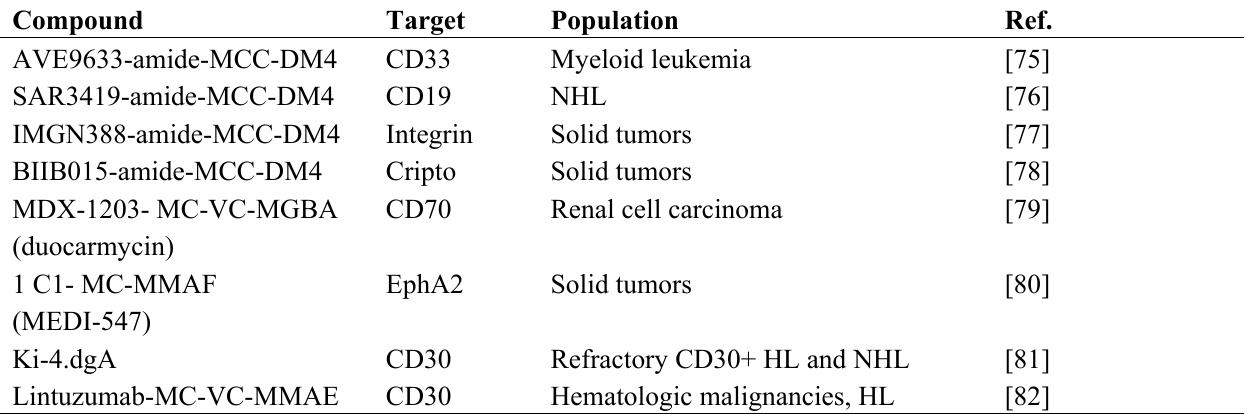
Table 1. Drug compounds and their targeted antigens and tissues in concluded or on-going phase I trials over the last